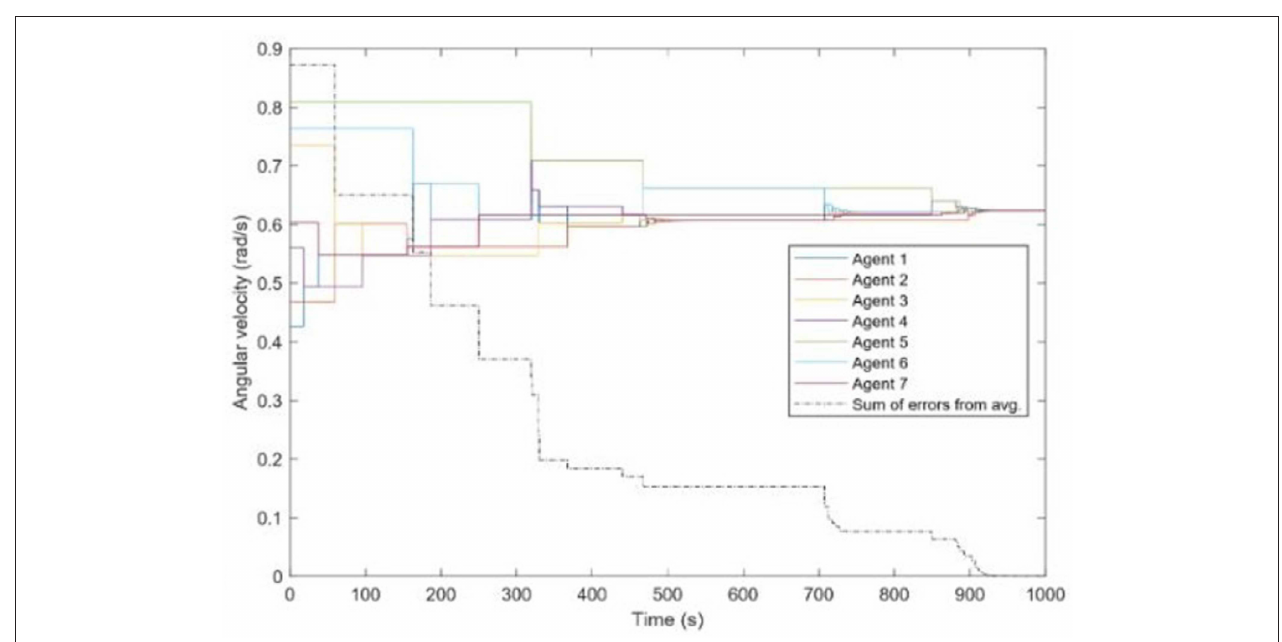
FIGURE 7 | Seven agents converge to the same frequency; the black dash line shows how 1 ( t ) decreases.